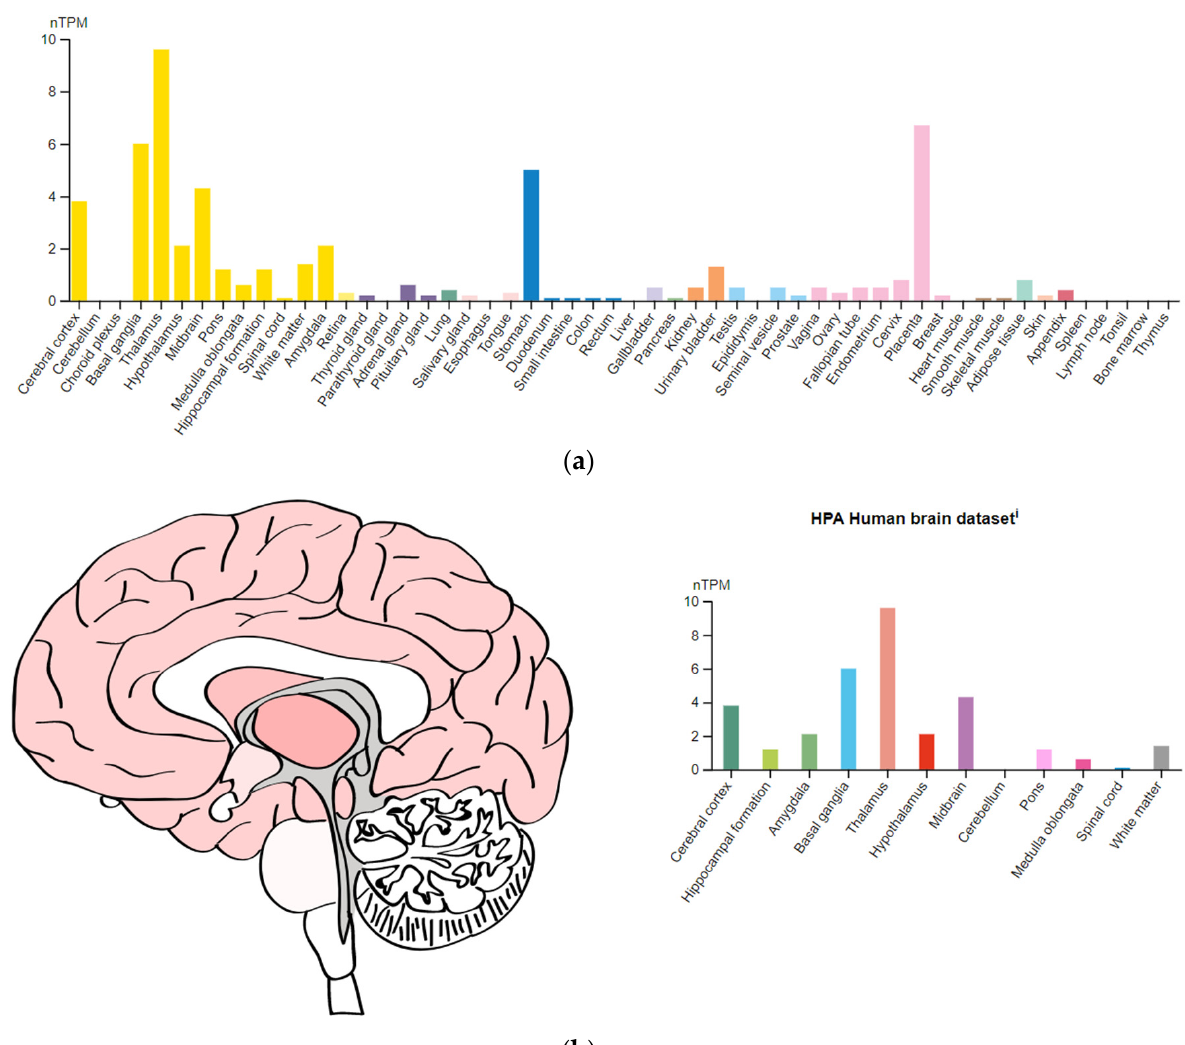
Figure A5. Expression of the HTR1B gene in the human body ( a ) and the brain ( b ) [122].